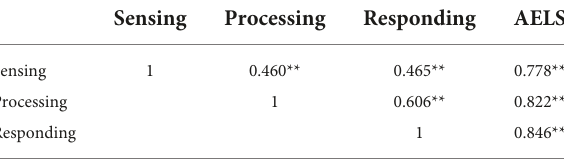
TABLE 5 Intercorrelations of active-empathic listening scale (AELS) subscales. Sensing Processing Responding